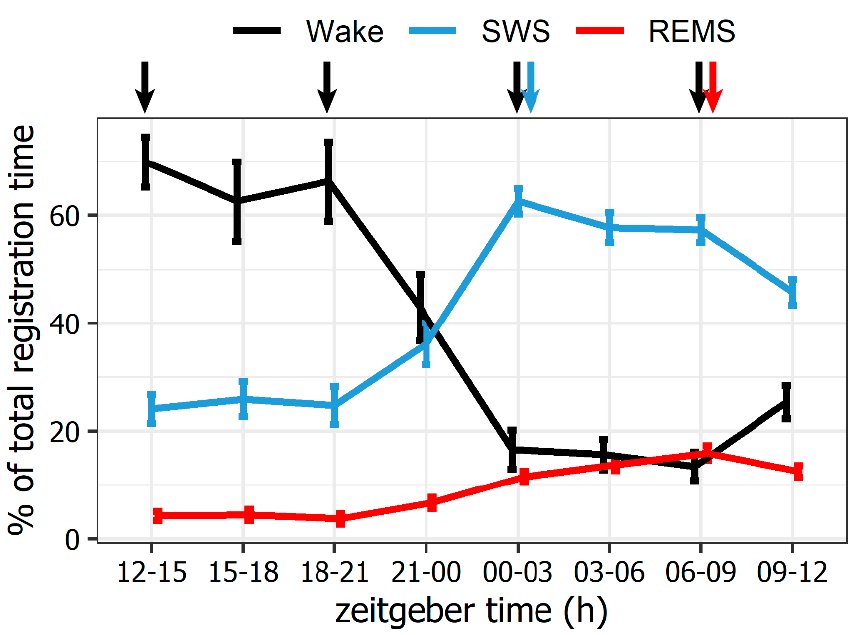
Figure 1. Total time of vigilance states comprising the natural daily sleep–wake cycle in Wistar rats ( n = 10). The natural daily maximum of slow-wave sleep (SWS) is registered after the sleep onset at ZT00-03, while REM sleep (REMS) peaks at the end of the inactive (lights-on) period at ZT06-09. Y-axis: % of total registration time. X-axis: zeitgeber time, hours. Arrows indicate the time points when 6 groups of rats ( n = 6 in each group) were sacrificed at daily maximums of wakefulness (ZT 12-15; 18-21), SWS (ZT00-03) and REMS (ZT06-09) for the subsequent real-time qPCR analysis of the brain tissue. Colours signify the preceding vigilance state: black—wakefulness, blue—slow-wave sleep, red—REM sleep. Values are shown as mean ± s.e.m, n =10 rats.